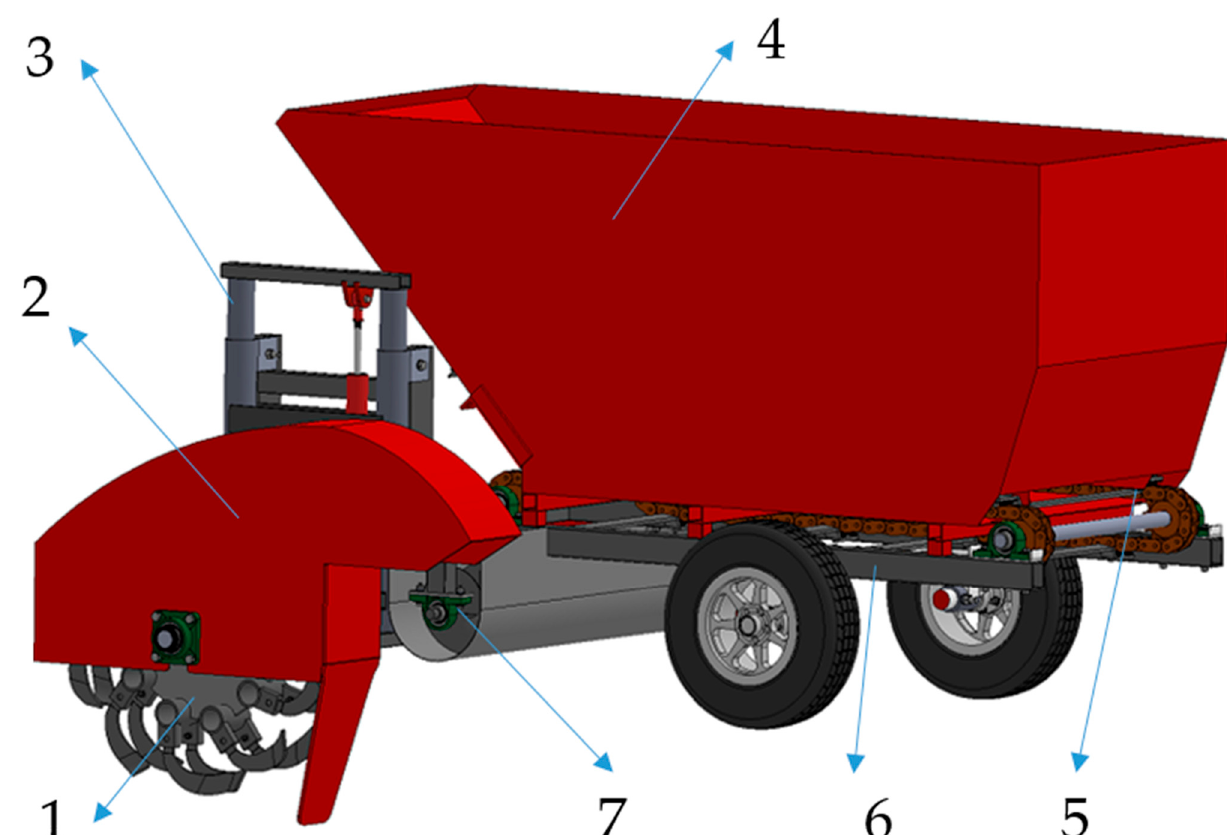
Figure 1. Schematic diagram of the structure of the deep fertilizing machine for orchard manure.